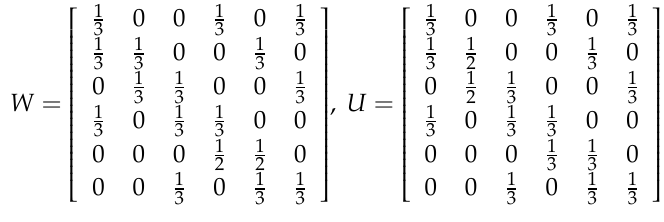
Figure 7. The communication topology of Distributed Generators (DGs).